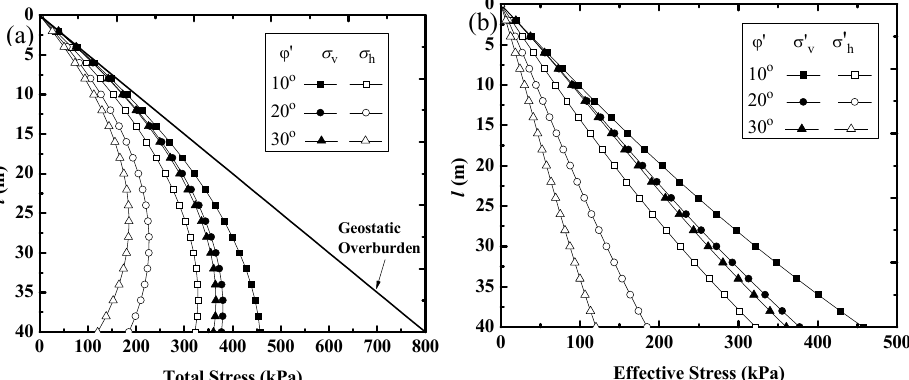
Figure 8. Distribution of the horizontal and vertical total ( a ) and effective ( b ) stresses with different effective friction angle ϕ ’ along the full height of the backfilled stope when the deposition ceases, predicted by the proposed solution (Equations (28)–(31)) by using H = 40 m, B = 6 m, c v = 5 m 2 /h, m = 0.2 m/h, γ w = 10 kN/m 3 , γ = 20 kN/m 3 and K = K a